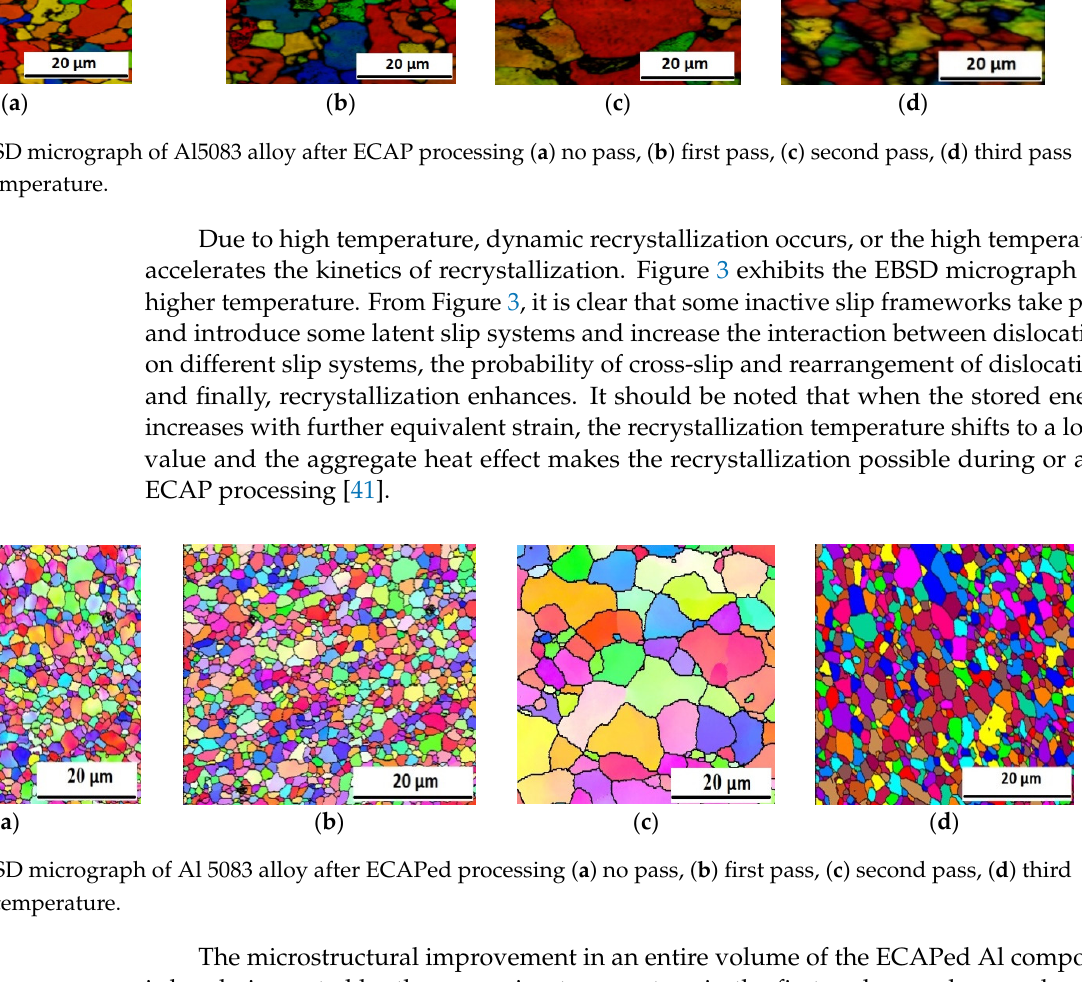
Figure 3. EBSD micrograph of Al 5083 alloy after ECAPed processing ( a ) no pass, ( b ) first pass, ( c ) second pass, ( d ) third pass at high temperature.